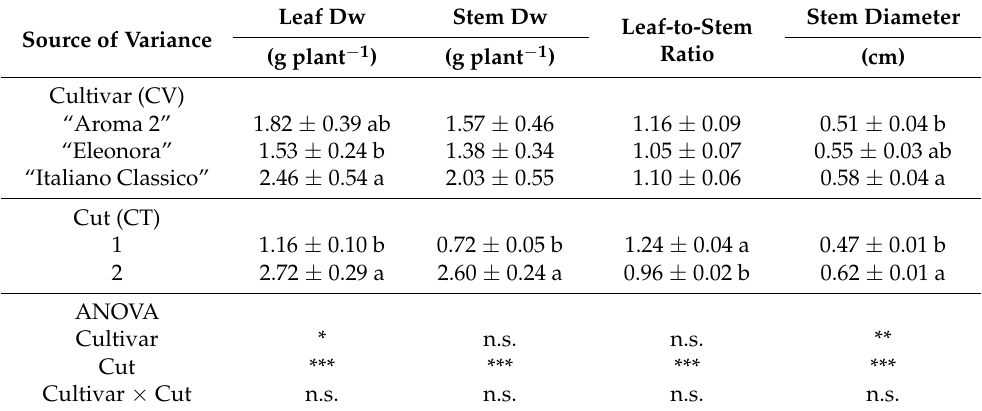
Table 2. Effect of cultivar and cut on leaf dry weight, stem dry weight, leaf-to-stem ratio, and stem